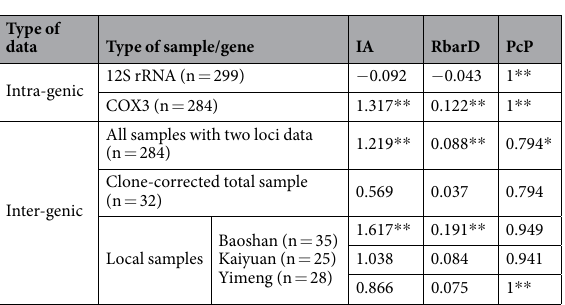
Table 5. Evidence for recombination between mitochondrial loci 12S rRNA and COX3 in natural populations of Th. ganbajun from China. I A : Multilocus index of association, RbarD: Multilocus index of association corrected for the number of loci, PcP: proportion of pairs of loci that are phylogenetically compatible. “ * ” and “ ** ” indicate significance P < 0.05 and P < 0.01,